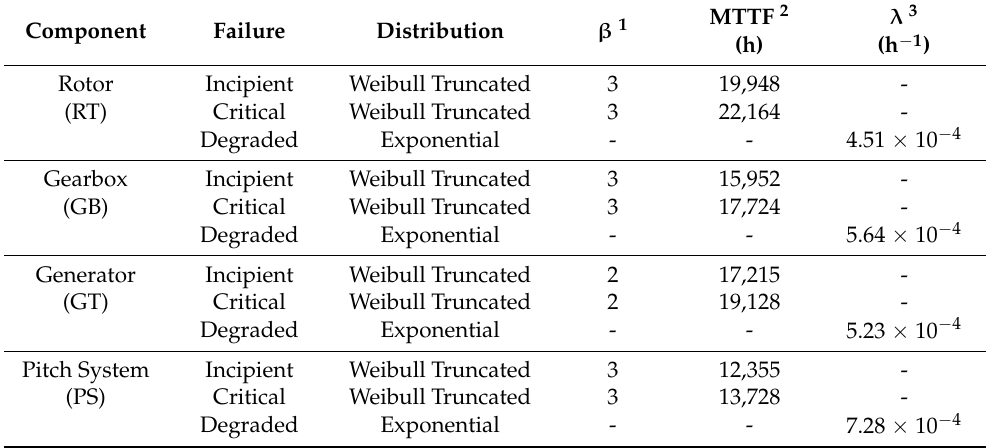
Table 1. Component failure data.